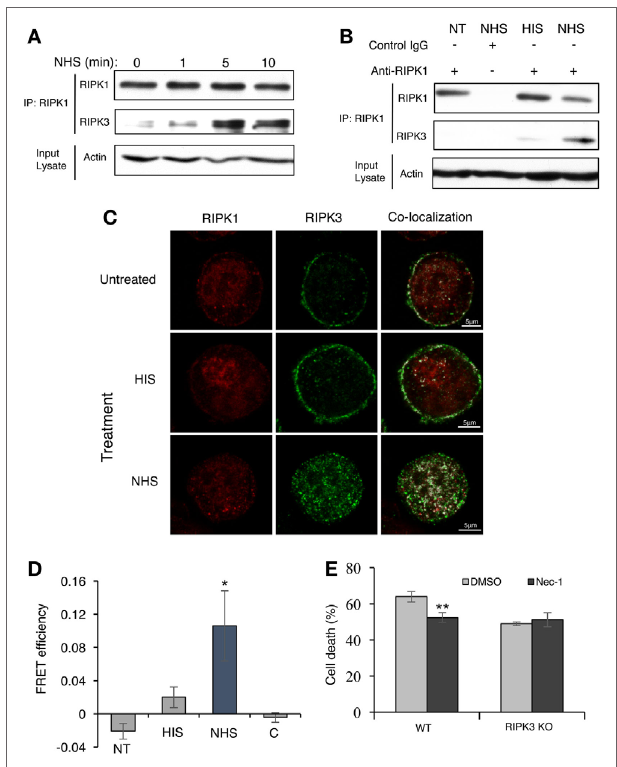
FigUre 3 | Complement triggers receptor-interacting protein kinase 1 (RIPK1) and receptor-interacting protein kinase 3 (RIPK3) complex formation. (a) Flag-RIPK3 transfected K562 cells were treated with a sublytic dose of antibody and complement for the indicated times. Cell lysates were immunoprecipitated with anti-RIPK1 antibody. Immunocomplexes were subjected to Western blotting with anti-RIPK1 or anti-Flag antibodies. Aliquots of cell lysates (Input lysate) were also analyzed for the amount of actin. (B) Flag-RIPK3 transfected K562 cells were treated with a sublytic dose of antibody and complement for 10 min at 37°C. Cell lysates were immunoprecipitated with anti-RIPK1 antibody or with goat IgG as control. Controls included cells treated with HIS (heat-inactivated serum) or untreated cells [not transfected (NT)]. RIPK1, RIPK3, and actin were detected as above. (c) Flag-RIPK3 K562 cells were treated with a sublytic dose of antibody and then with complement (or HIS) for 10 min at 37°C. Cells were fixed and permeabilized. RIPK3 was detected by using anti-Flag antibody followed by AF488-labeled secondary antibody. Endogenous RIPK1 was labeled with anti-RIPK1 antibody followed by AF546-labeled secondary antibody. After analysis by confocal microscopy, the RIPK1 and RIPK3 locations were merged by the Co-localization plugin in ImageJ software. (D) Flag-RIPK3 K562 cells were treated for 5 min with a sublytic dose of antibody and complement. Then, they were fixed and permeabilized. Prior to imaging, cells were treated with goat anti-RIPK1 or mouse anti-FLAG antibodies, followed by AF546-labeled donkey anti-goat IgG or AF488-labeled donkey anti-mouse IgG secondary antibodies, respectively. Square ROI was photobleached and images were taken before and after bleaching. Shown are fluorescence resonance energy transfer (FRET) efficiencies normalized to the bleaching percentage of the acceptor. Control (C) is the FRET efficiency outside the bleached regions [in normal human serum (NHS)-treated cells] * P < 0.05 relative to HIS. (e) WT and RIPK3 KO mouse embryonic fibroblasts were pretreated with Nec-1 (50 µM) or with DMSO as control and then treated with NHS for 1 h at 37°C. The percentage of cell death was determined by trypan blue inclusion. Data were represented as mean ± SD of triplicates. ** P < 0.01 relative to DMSO. All experiments were repeated at least three times with similar results.